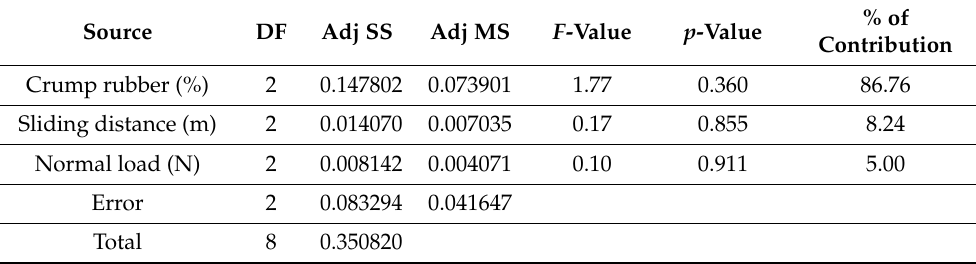
Table 10. ANOVA analysis for the coefficient of